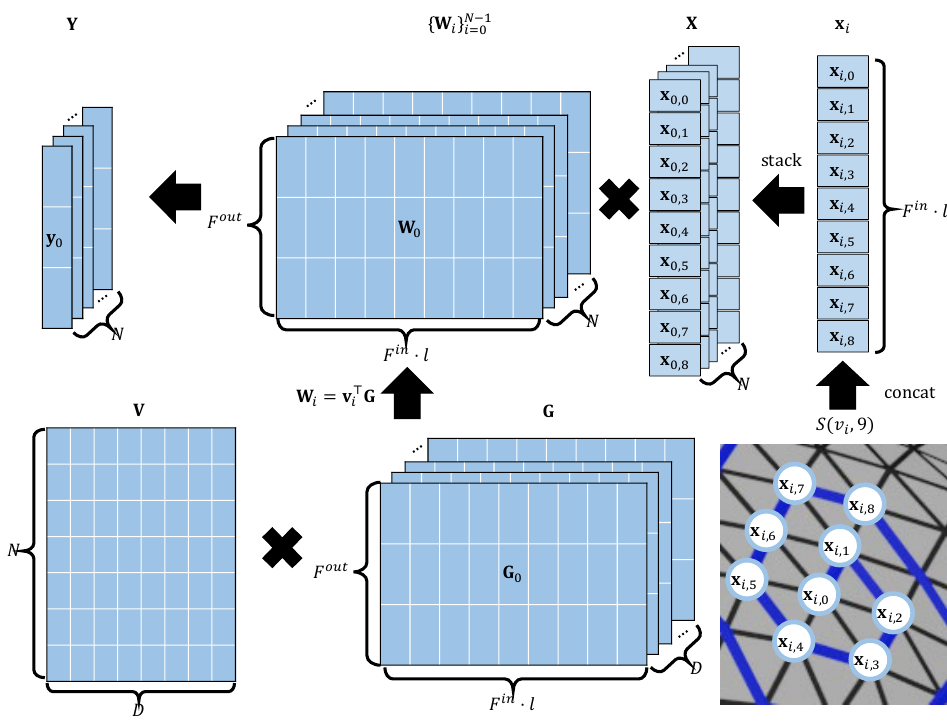
Figure 4. In the proposed anisotropic spiral convolution method, the spiral sequences S ( v i , l = 9 ) corresponding to the i -th vertex feature are concatenated from x i ,0 , x i ,1 ,..., x i ,8 ; this is denoted as x i . We linearly parameterize the convolutional filter weights { W i } N − 1 G ∈ R D × F out × F in · l and their coefficients V ∈ R N × D to ensure that each vertex has a different and desired convolutional filter. In doing so, our method enhances the representation power compared to the conventional isotropic convolutional